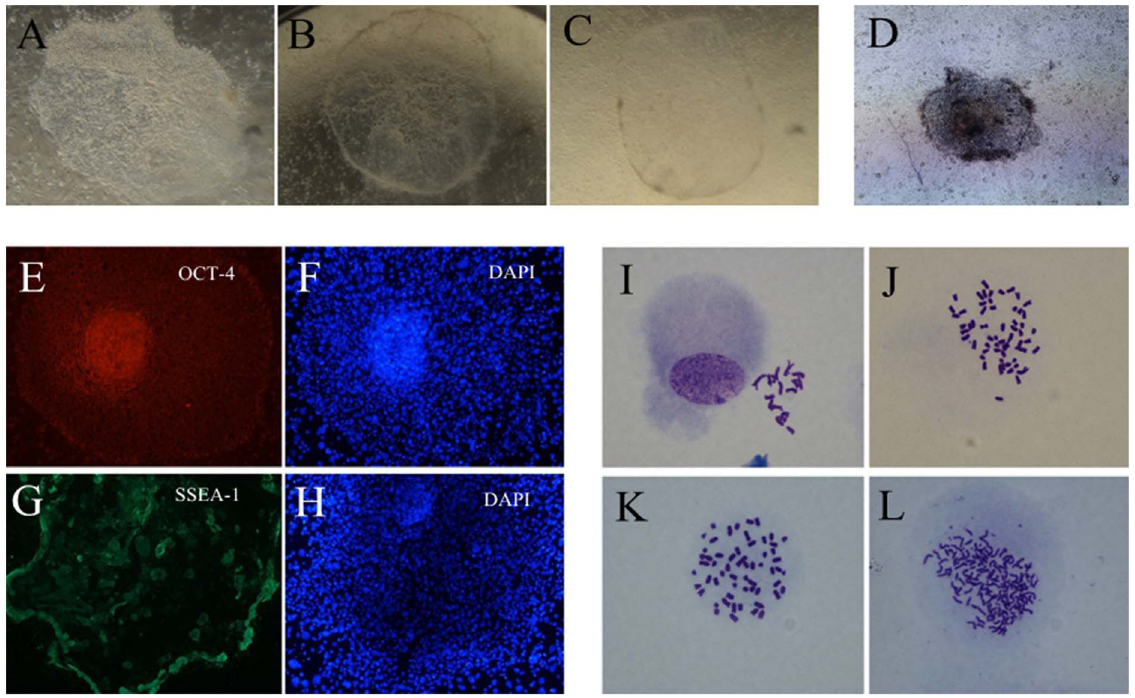
Figure 2. The morphology, immunofluorescence staining and chromosome spread of PA embryo-derived embryonic stem-like cells. (A–C) The primary stem-like cell colonies: A from whole blastocyst, B and C from inner cell masses (ICMs). The stem-like cell colony from whole blastocysts contains large amounts of lipid droplets. (D) A stem-like cell colony that is alkaline phosphatase positive. (E and F) OCT4 immunofluorescence staining and corresponding DAPI staining. (G and H) SSEA-1 immunofluorescence staining and corresponding DAPI staining. (I– L) The aneuploid chromosome spread of the ICM-derived cell lines, contain 17, 57, 54 and uncounted chromosomes, respectively.